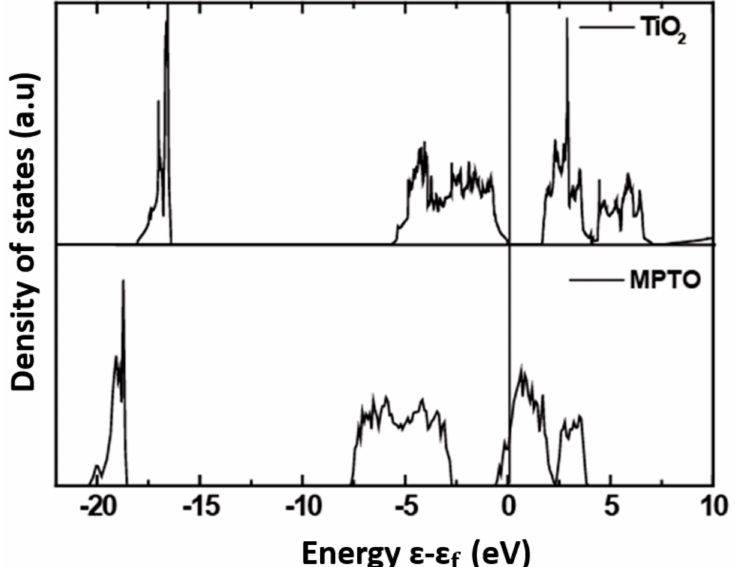
Figure 7. Density of state (DOS) for TiO 2 (up) and Ti 4 O 7 (bottom),